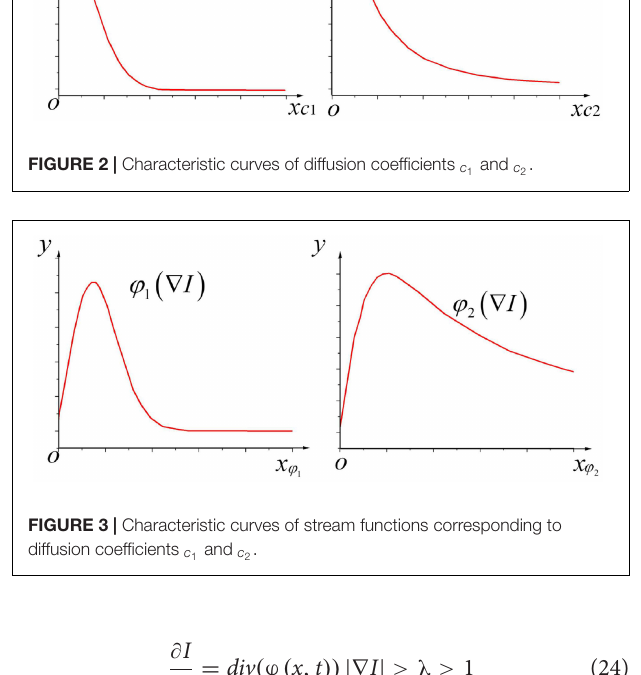
Frontiers in Neuroscience |